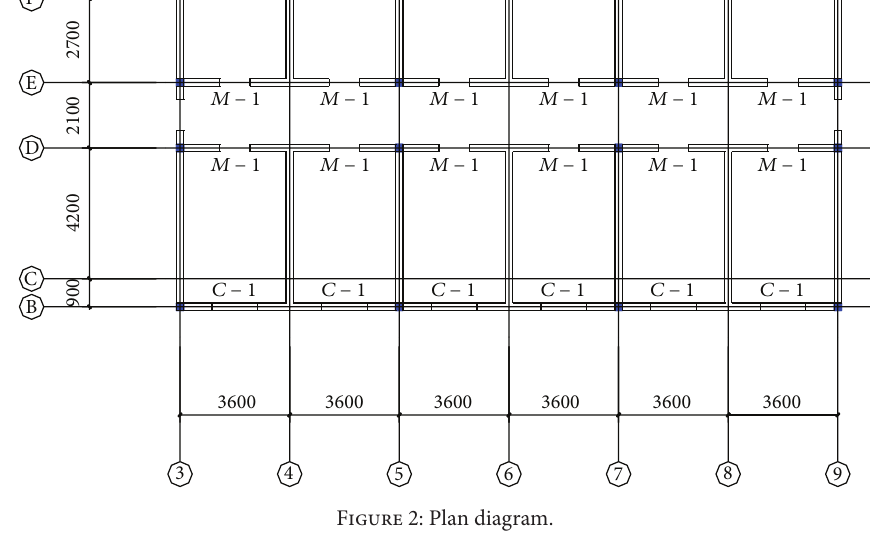
Figure 2: Plan diagram.